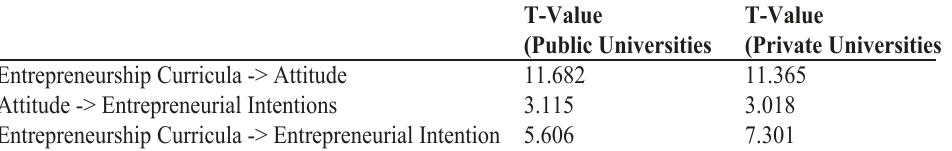
Comparison Based on T-Value